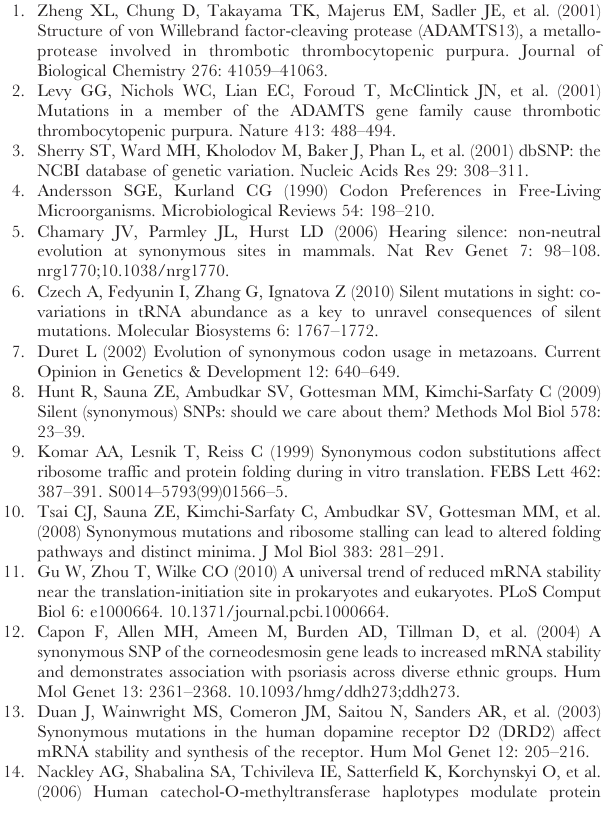
Table S1 Changes in predicted binding motif of splicing site regulators between variant and WT using SPmap